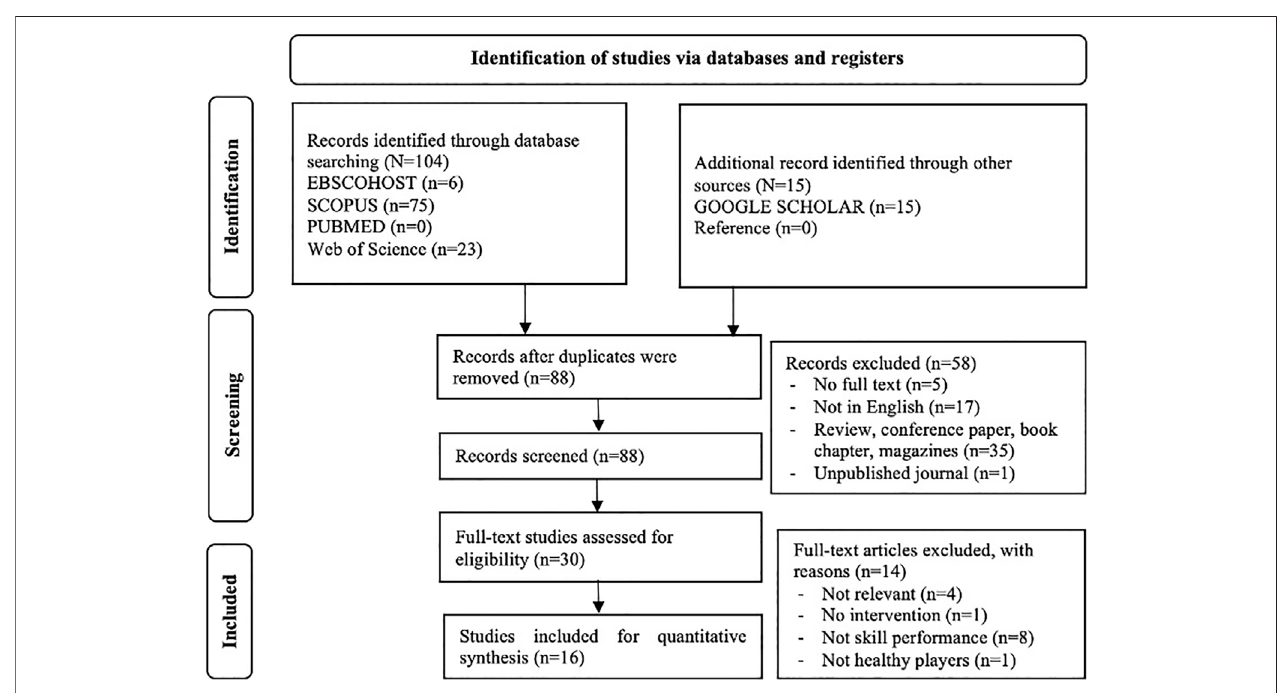
FIGURE 1 | The search, screening and selection processes for suitable studies – based on PRISMA.